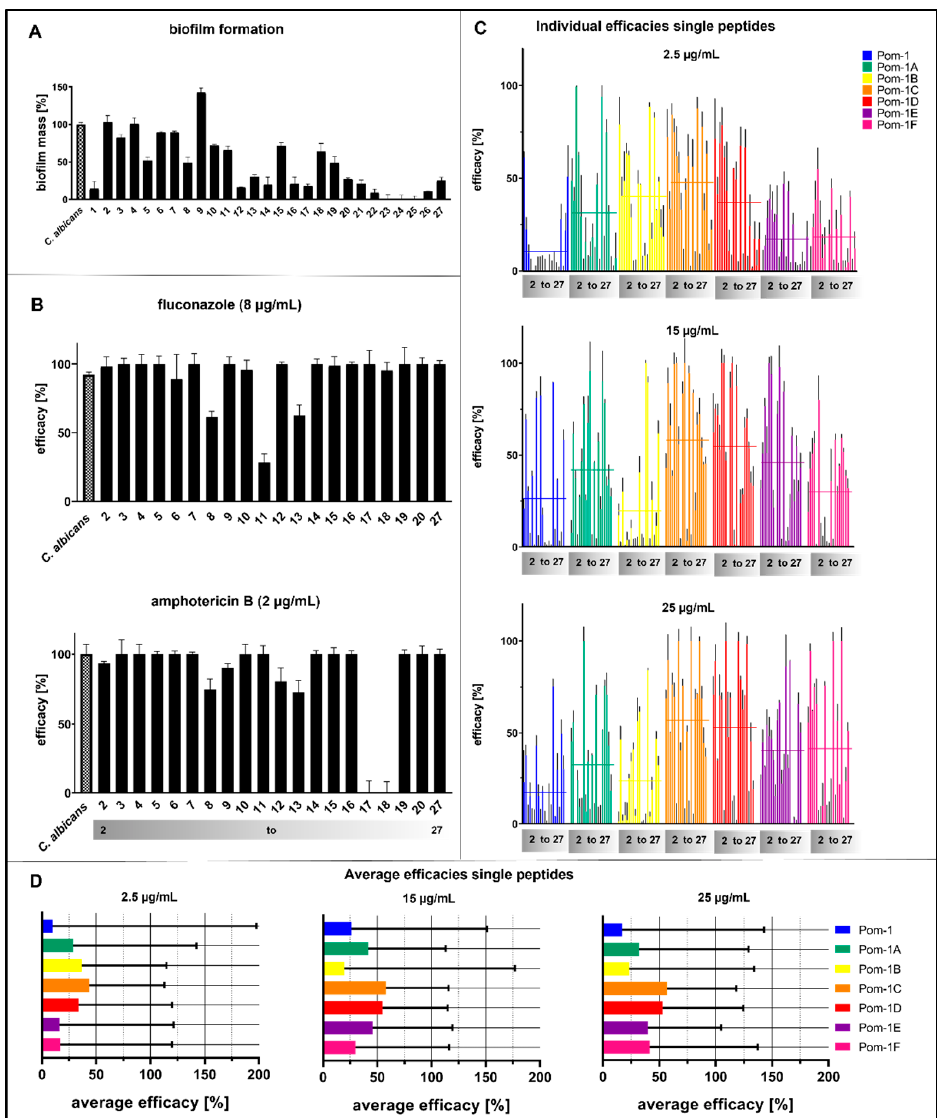
Figure 3. Detection of the biomass and antifungal activity of Pom-1 derivatives towards biofilm formation of invasive C. albicans clinical isolates by crystal violet assay. All the experiments were performed in triplicate, and the error bars depict the standard deviations. ( A ) Biofilm formation of Candida isolates without an agent. A laboratory strain of C. albicans was used as a reference. The Candida isolates were named with numbers. ( B ) Effect of fluconazole and amphotericin B on biofilm formation of the clinical isolates. The maximum inhibitory concentrations of 8 µ g/mL for fluconazole and 2 µ g/mL for amphotericin B were used. The Candida isolates were named with numbers. The grey bar was added to indicate the isolates to allow more transparency in the following figures (2–27). ( C ) Evaluated effects of 2.5 µ g/mL (MIC), 15 µ g/mL, and 25 µ g/mL Pom-1A to Pom-1F on the